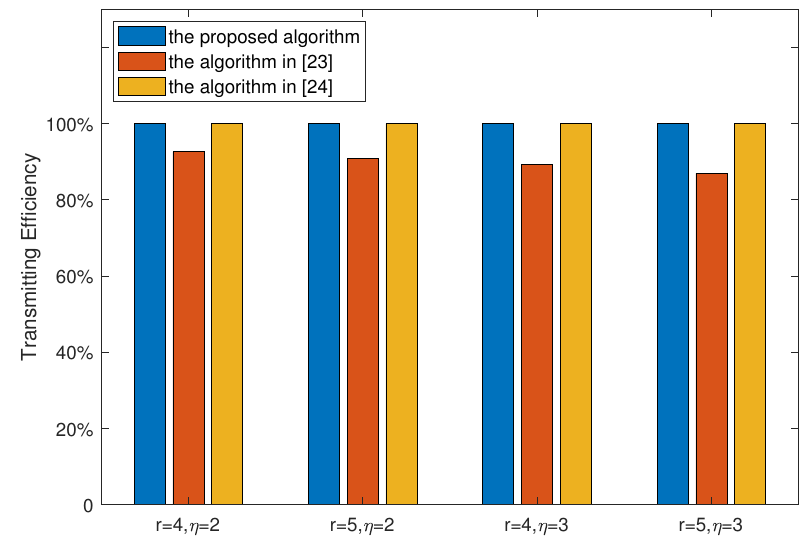
Figure 12. Efficiency comparison of different turbo-Hadamard